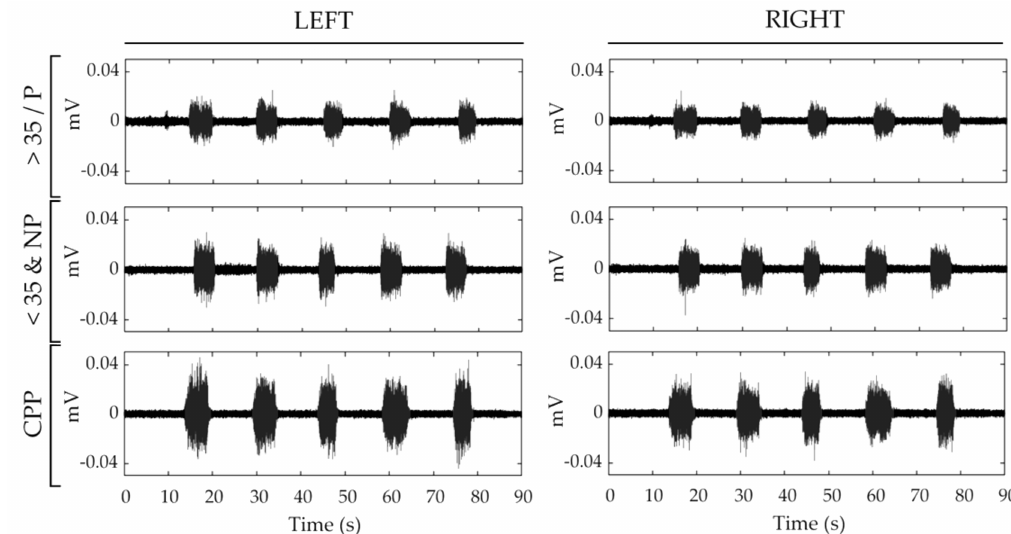
Figure 2. sEMG signals recorded from the pelvic floor musculature (PFM) of a subject from each group: woman over 35 and/or parous (>35/P, first row), woman under 35 and nulliparous (<35&NP, second row) and woman with Chronic pelvic pain (CPP, third row). Left and right subfigures show signals recorded from each subject’s left and right PFM,